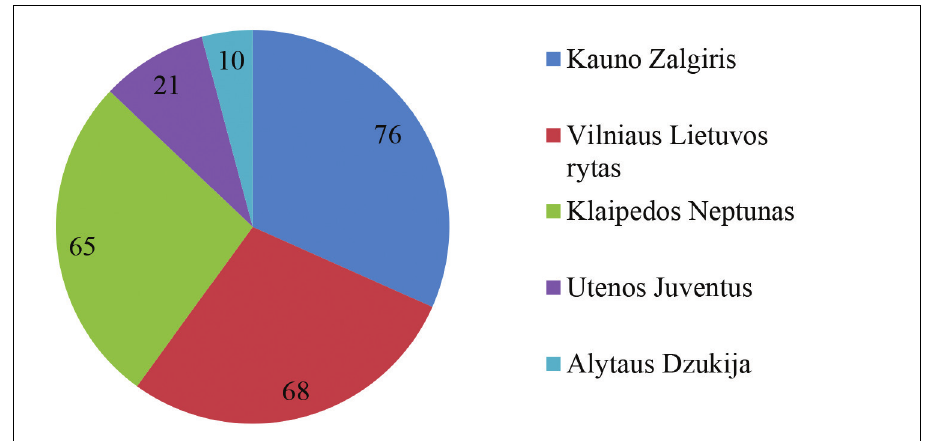
Figure 4. Distribution of the basketball club